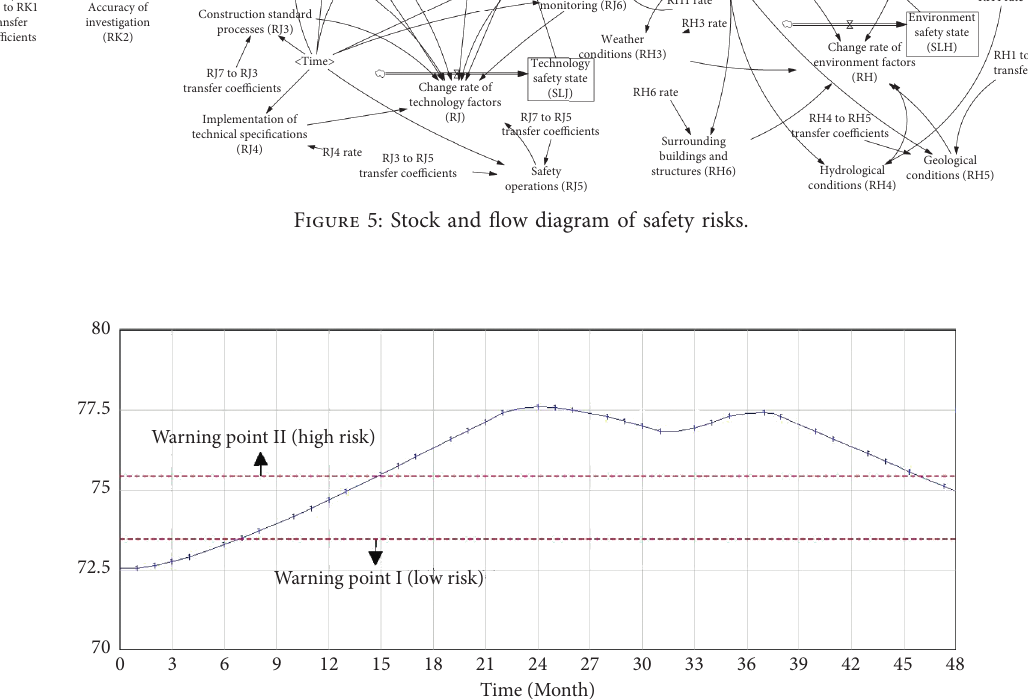
Figure 6: Developing trend of the overall safety state level for Line 9